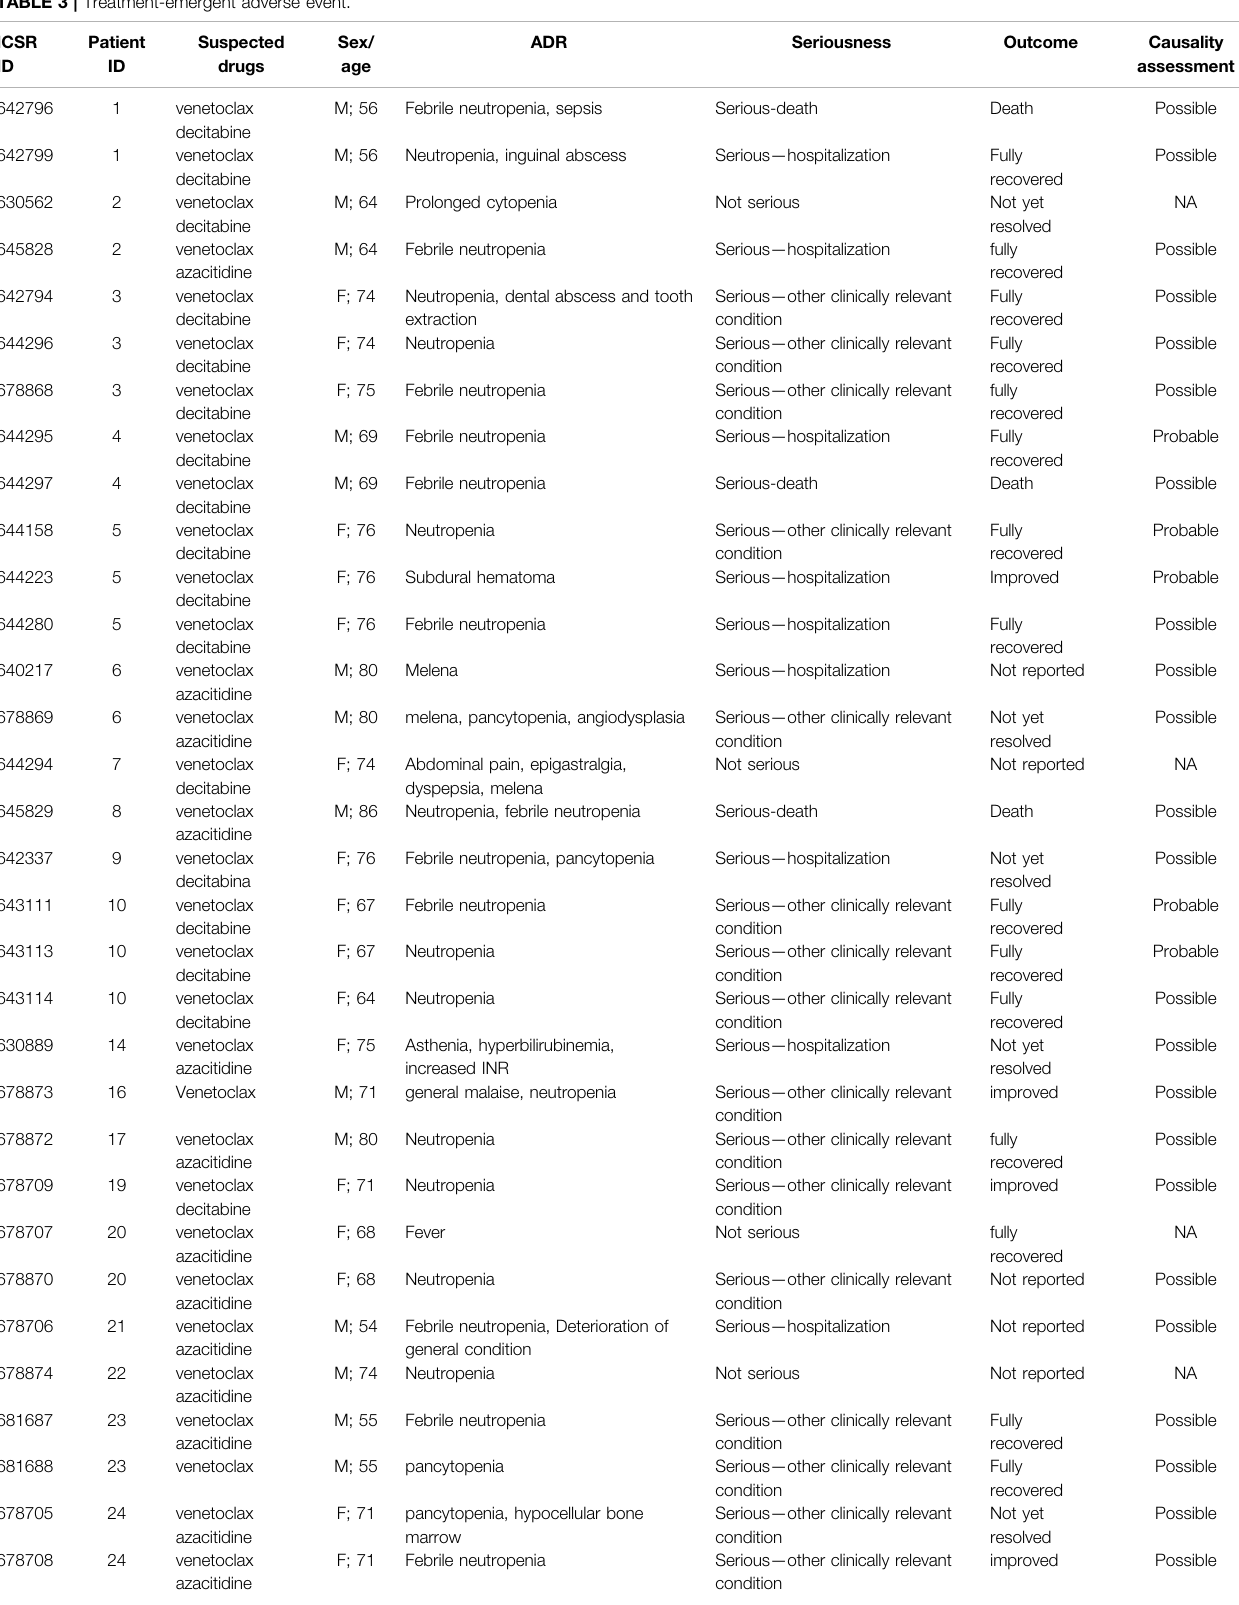
TABLE 3 | Treatment-emergent adverse event. ICSR